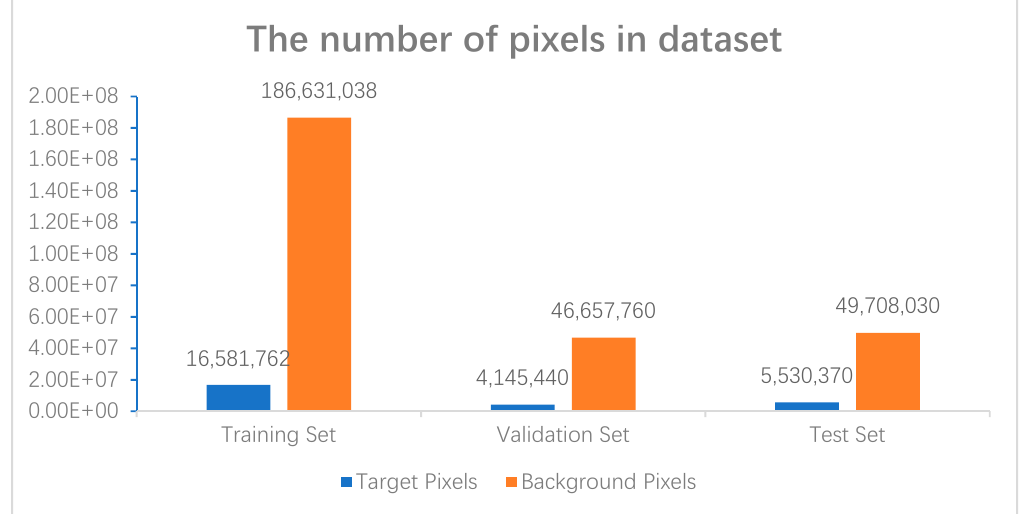
Figure 7. The number of pixels in dataset.